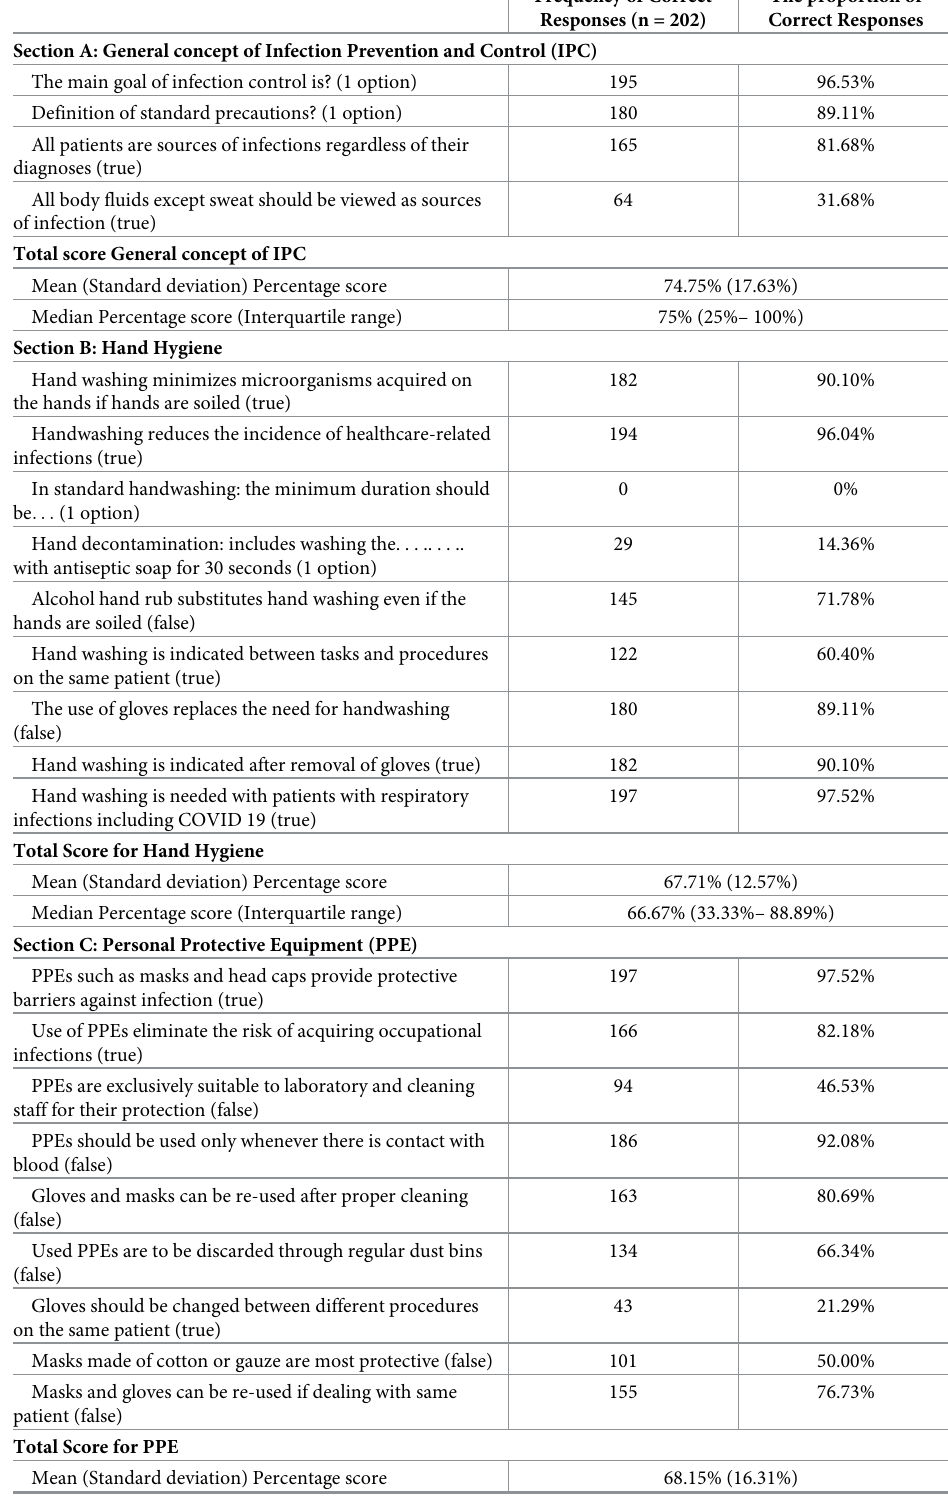
Table 2. Proportion of correct responses in knowledge on various aspects of infection prevention and